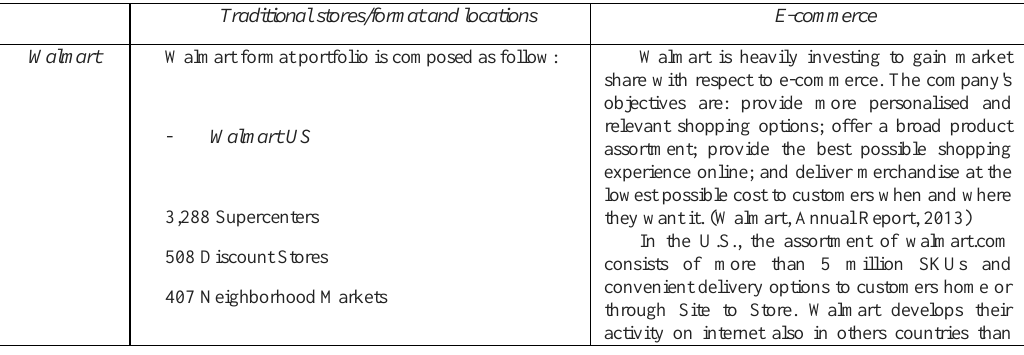
Table 7: Traditional Stores and some Innovative Stores/Channels (Focus on E- Commerce) of the three Largest Global Retailers Ranked by Revenue Traditional stores/format and